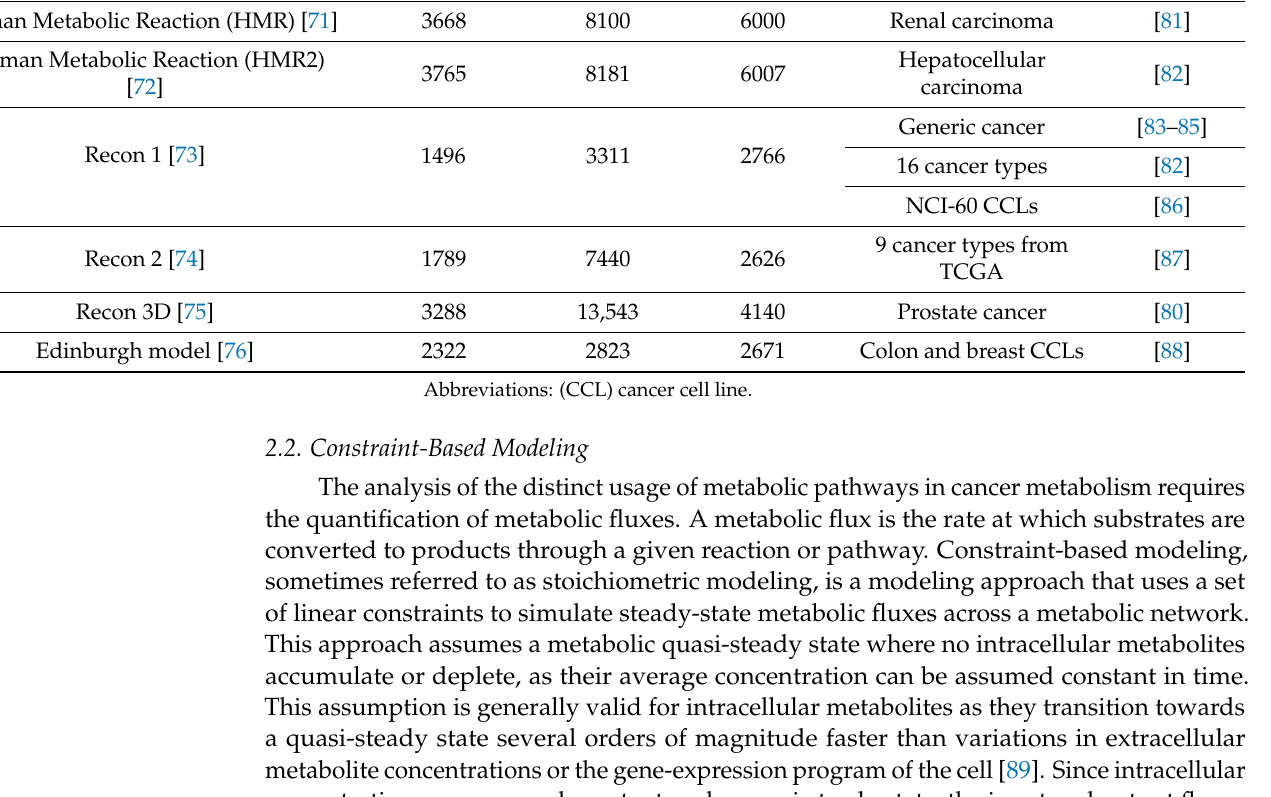
Table 1. Human metabolic generic models and their complexity in terms of number of genes, reactions and metabolites. Adapted from [79]. Human Generic